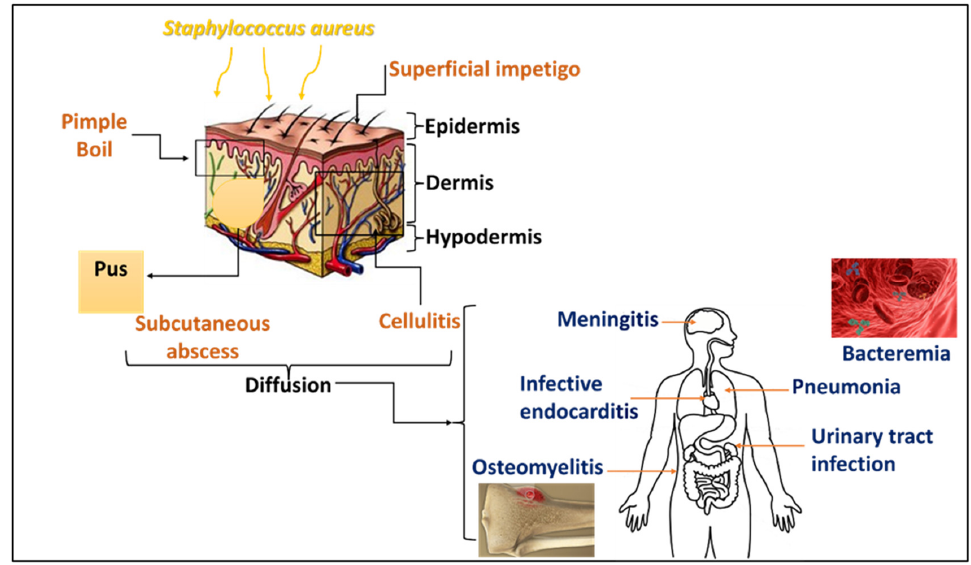
Figure 1. Skin colonization by Staphylococcus aureus and the resulting infections (By Zeouk, 2022) Skin infections